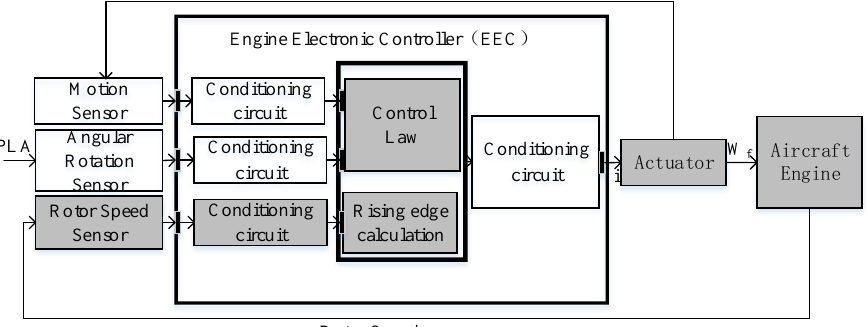
Figure 2. Closed-loop speed control diagram.